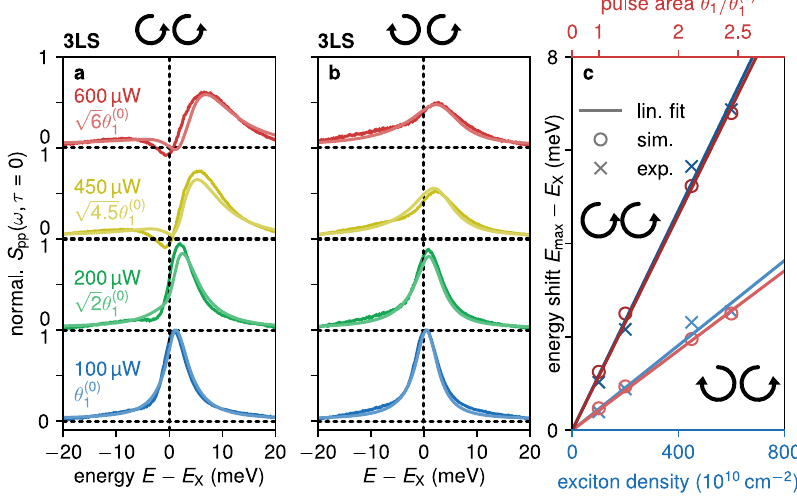
Figure 5: Pump-probe spectra at pulse over- lap. (a) Co-circular polarization with exper- iment in dark and simulation in the 3LS in bright colors. For the smallest pulse area 2 V = ℏ𝜃 (0) 2 W = 2 . 4 meV. we have ℏ𝜃 (0) 1 1